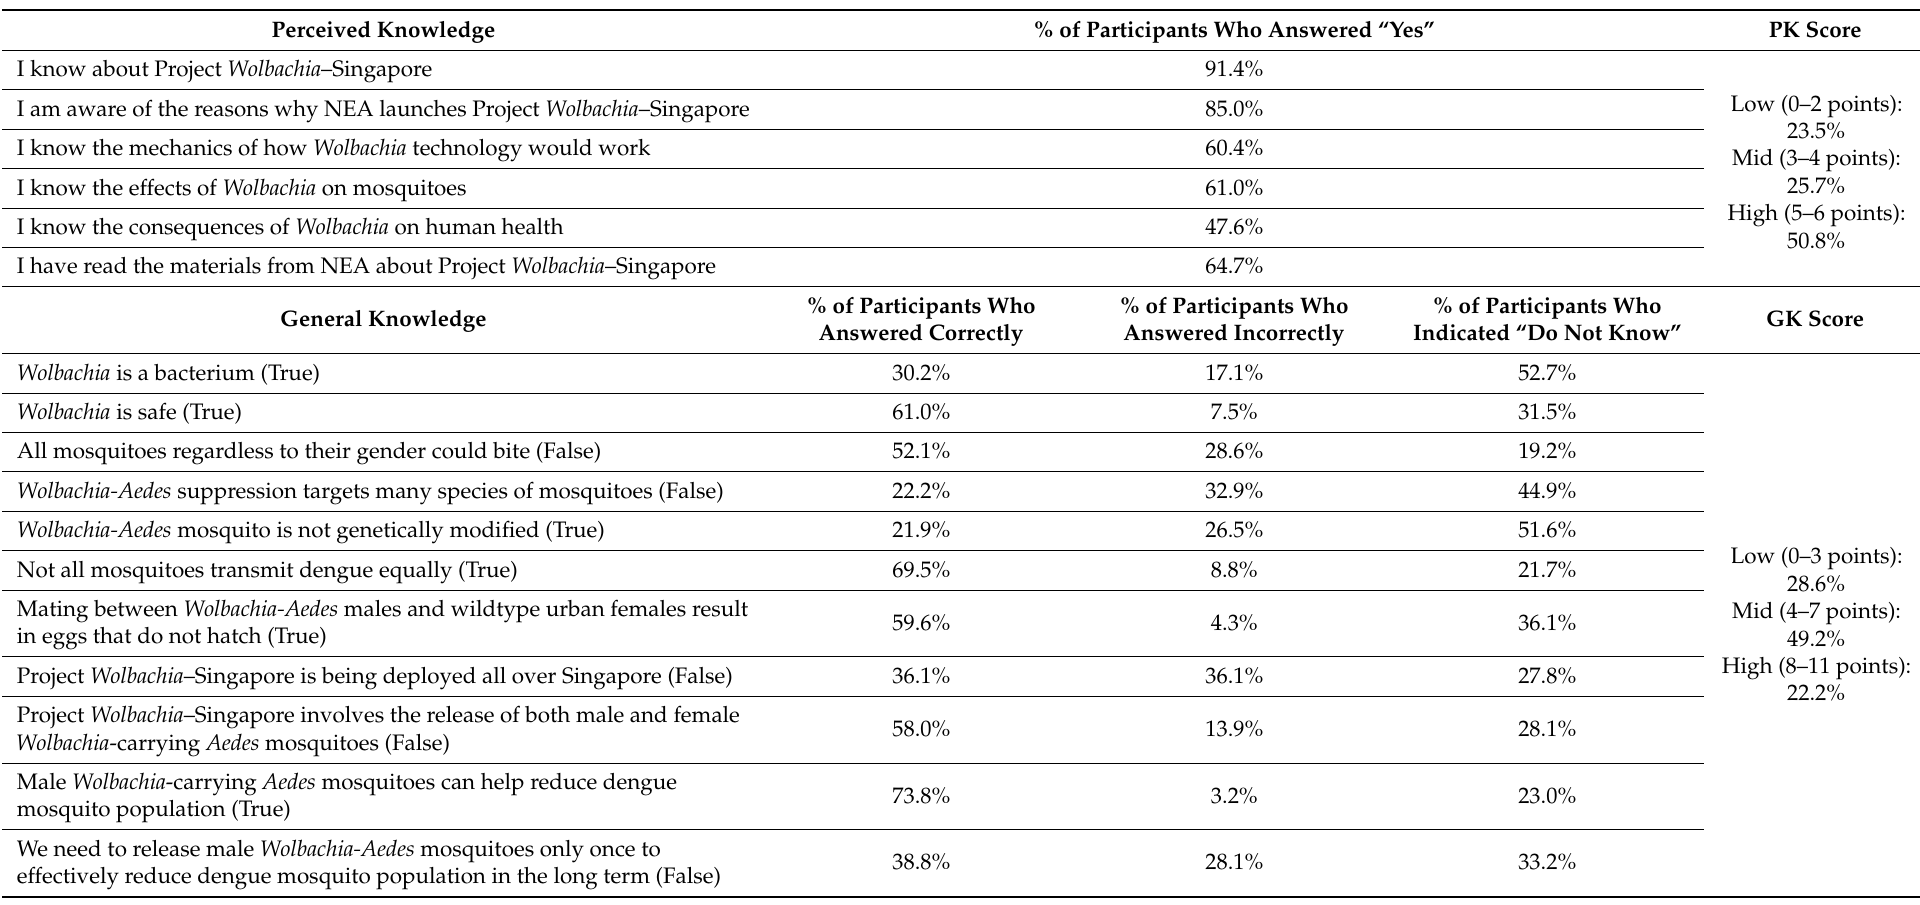
Table 3. Categorised perceived knowledge (PK) and general knowledge (GK) scores among participants who have heard of Project Wolbachia– Singapore. Perceived